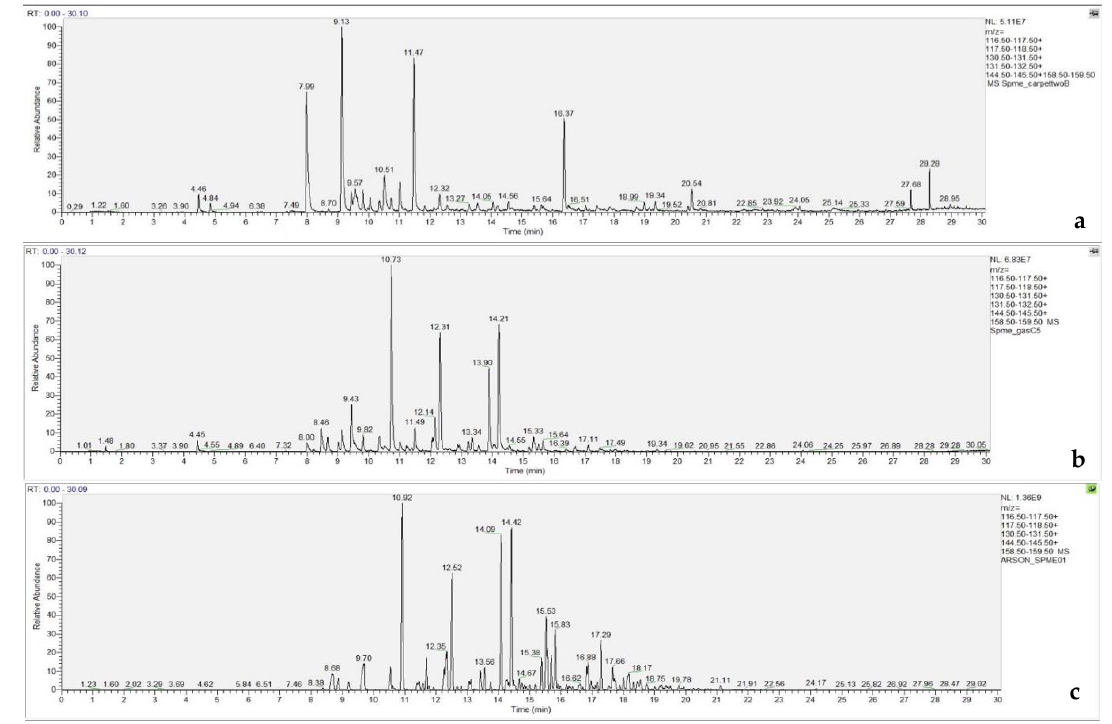
Figure 9. Extracted indane profiles of ( a ) carpet #2, burned without ILs; ( b ) carpet #2 burned with gasoline; and ( c ) neat gasoline.